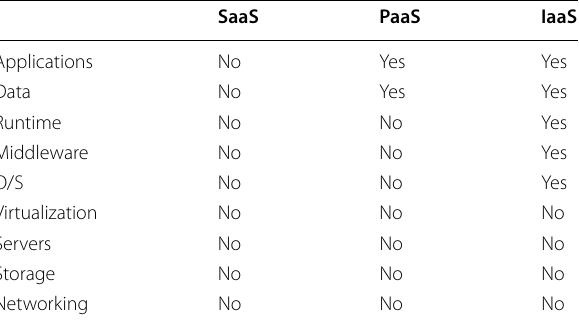
tools. The IaaS means the provider shares the IT Infra- structure to users, which releases the need to purchase and maintain the infrastructure. Table 4 Need of user management in different models of cloud